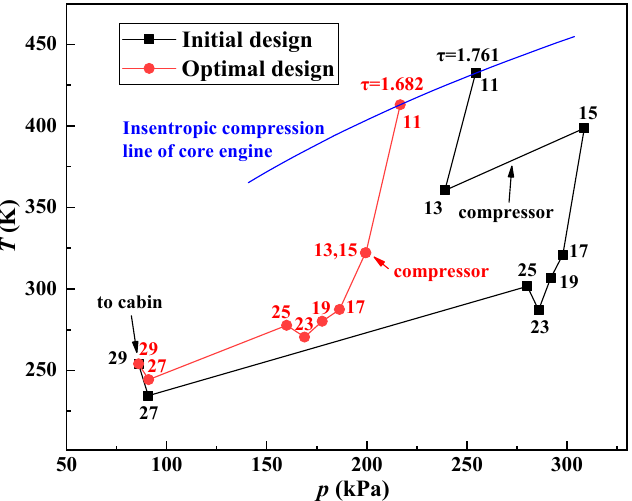
Figure 9. Thermodynamic cycle of the bleed air.